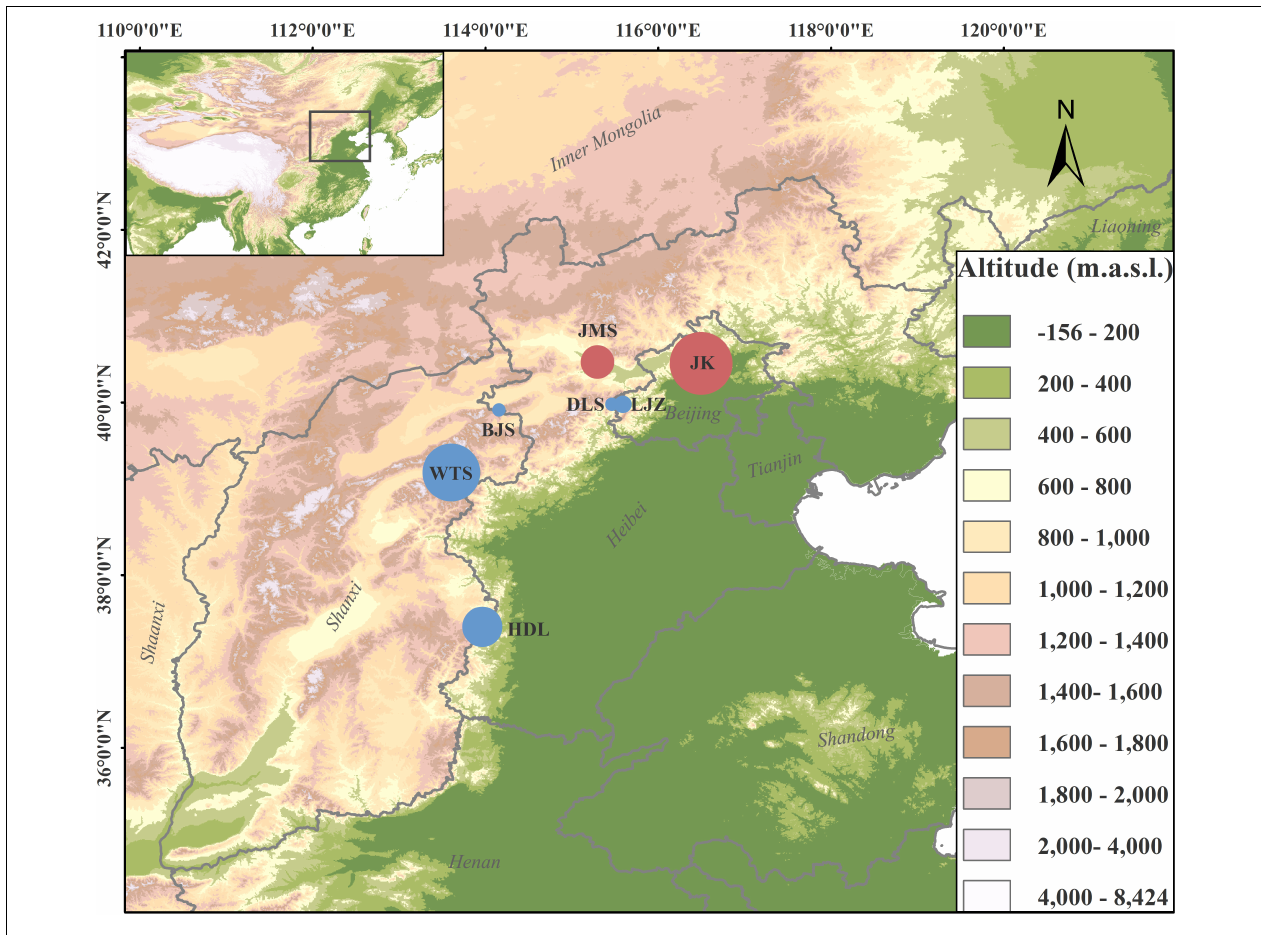
FIGURE 1 | Geographic distributions of sampled Lonicera oblata populations. The two red circles on the northside represent populations from Yan Mountains, and the five blue circles represent populations from Taihang Mountains. The circle size corresponds to the population sample